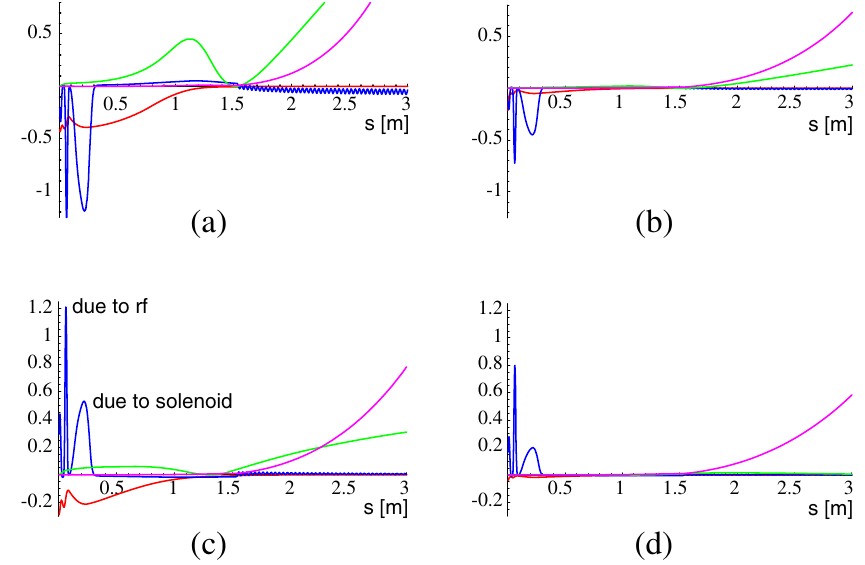
FIG. 2. (Color) Magnitudes of the four dimensionless driving terms in Eq. (4) as a function of s . The curves are, respectively, the (cid:1) (cid:1) in red, the chromatic term (cid:2) (cid:2) space-charge term (cid:2) (cid:2) s (cid:1) (cid:2) s ^ (cid:1) Plots (a) and (b) are for the 3rd and 10th slices from the bunch head. Plots (c) and (d) are for the 3rd and 10th slices from the tail.